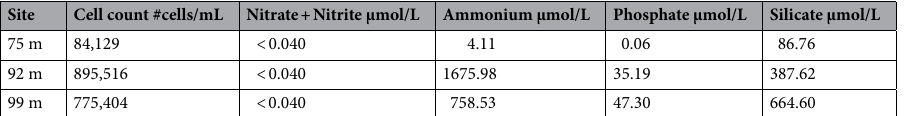
Table 1. Summary of anoxic lake properties, including cell counts and dissolved nutrients.